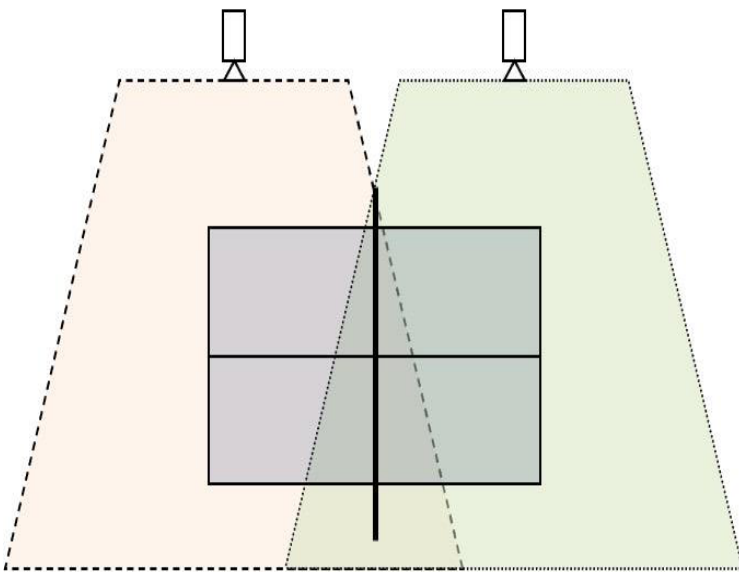
Figure 1. Video-recording protocol.